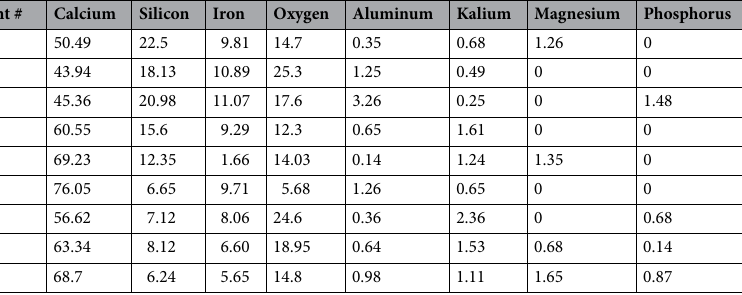
Table 4. Composition (wt %) by EDX analysis of LP0.45 with a scanning speed of 5 mm/s. Measured points are indicated in Fig.